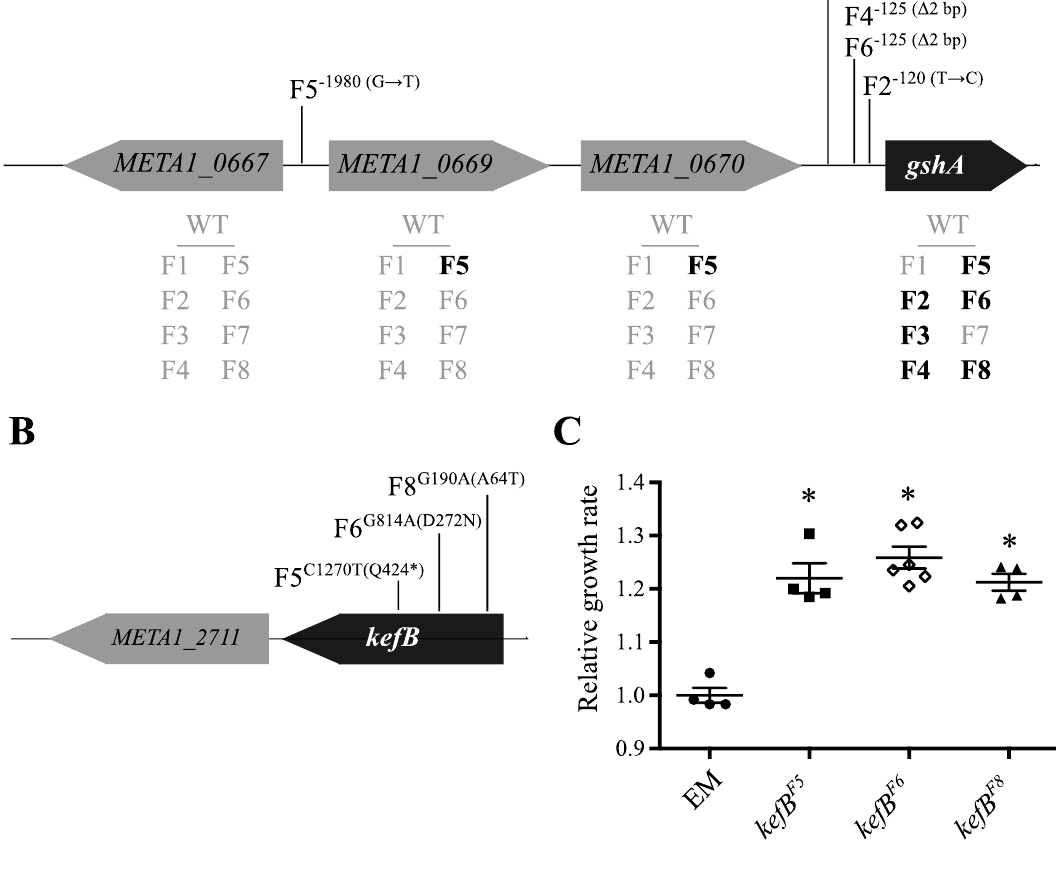
Figure 1. Parallel mutations to gshA and kefB occurred in multiple F lines. ( A ) Multiple mutations that appear to account for the observed increase in expression of gshA . Shown are evolved gshA alleles and increases in gene expression (bold) from microarray analysis. ( B ) The kefB locus was also targeted by parallel mutations in multiple F lines, and ( C ) each evolved allele was found to be beneficial in the EM background grown on methanol. Asterisk (*) indicates p < 0.05 in a two-tailed, unpaired t -test assuming unequal